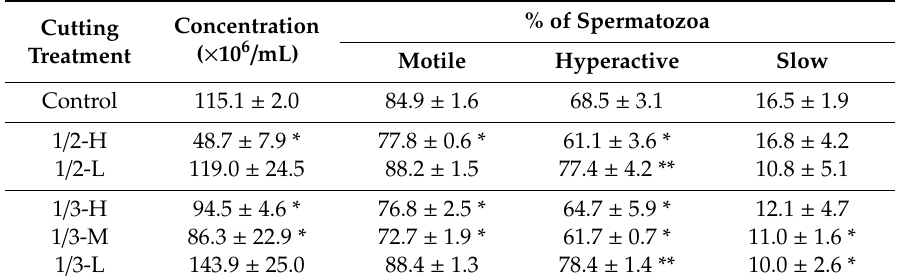
Table 1. The e ff ects of ultrasonic cutting on the sperm motility and activity of Korean Proven Bull Number (KPN) spermatozoa. Cutting